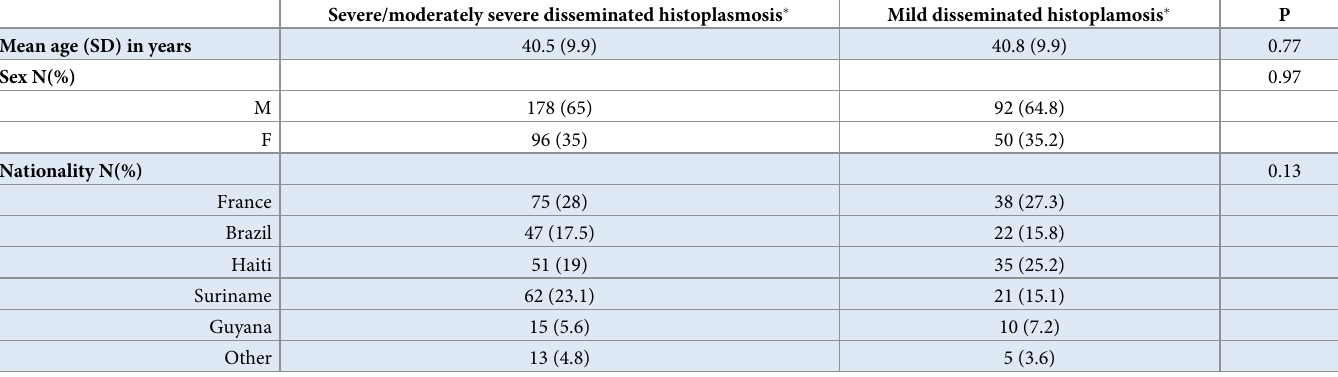
For physicians, 186 cases were treated with deoxycholate or liposomal amphotericin B (44.7%) and 230 (55.3%) cases were treated with itraconazole as first line treatment. Among those 186 Table 1. Sociodemographic data in severe/moderately severe vs mild HIV-associated disseminated histoplasmosis. Severe/moderately severe disseminated histoplasmosis